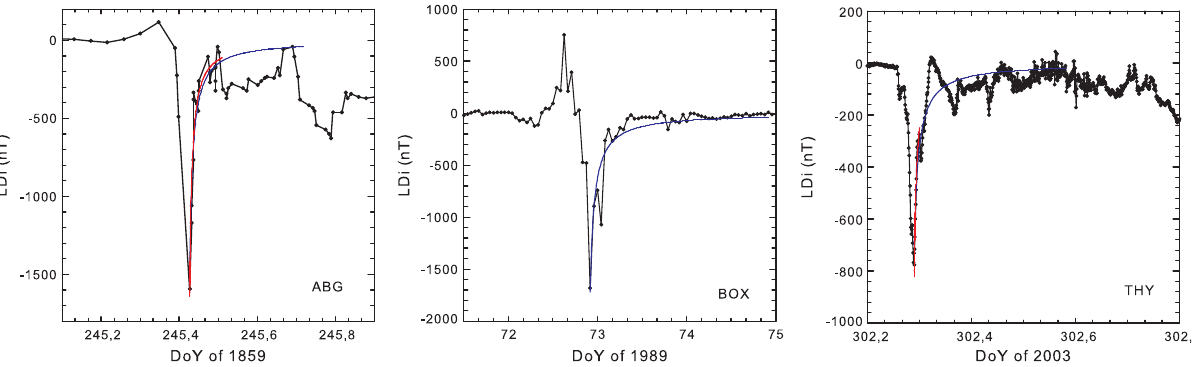
Fig. 5. Fitting results superposed to LDi for those analysed events (ABG, BOX, THY). Different colours indicate different time intervals in the fitting procedure: #1 (#2) results in Table 1 corresponds to red (blue) solid